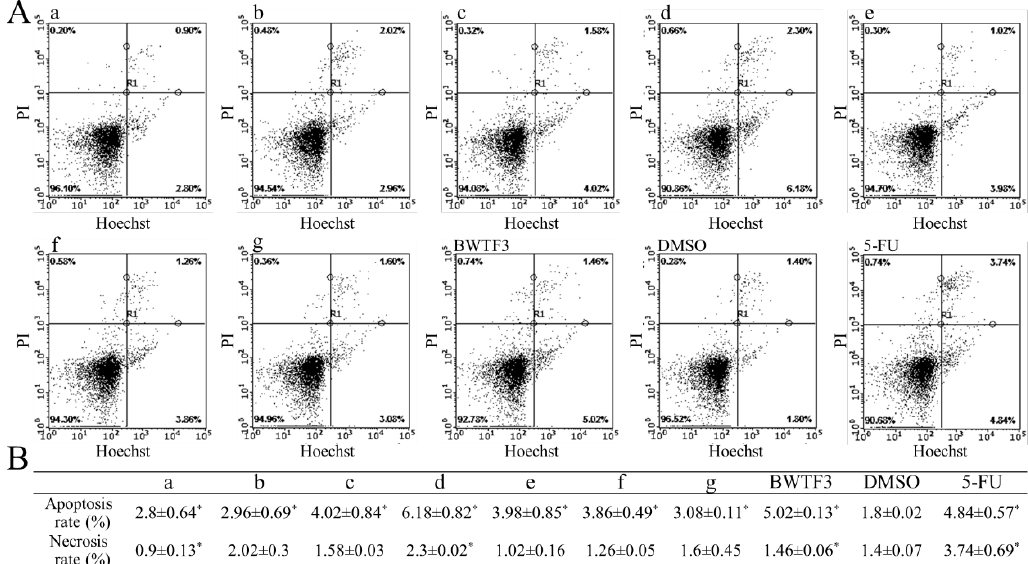
Figure 5. Effect of flavonoids on apoptosis of MGC80-3 cells. ( A ) the result of flow cytometry test. a – g indicates different proportion of quercetin and rutin ( a , rutin: quercetin = 50:0; b , rutin: quercetin = 40:10; c , rutin: quercetin = 30:20; d , rutin: quercetin = 25:25; e , rutin: quercetin = 20:30; f , rutin: quercetin = 10:40; g , rutin: quercetin = 0:50 (μ g/mL)). Dimethyl sulfoxide (DMSO), negative control; 5-